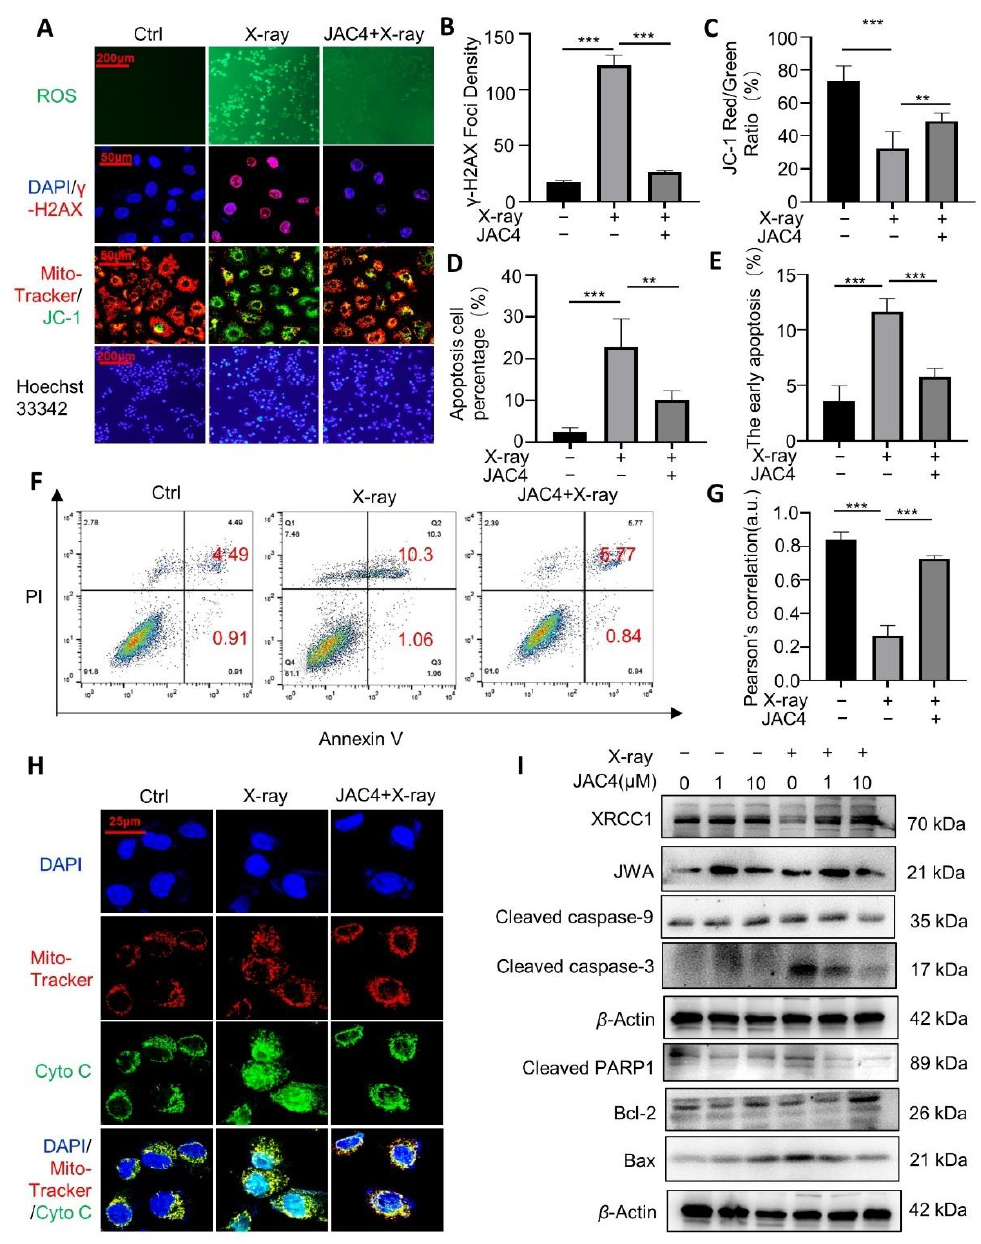
Figure 5. JAC4 attenuates X-ray-triggered oxidative stress and mitochondria damages in ICE-6 cells. ( A ) IEC-6 cells were pretreated with JAC4 (1 or 10 µ M) or DMSO for 24 h and then exposed to X-ray (12 Gy). ROS was detected by DCFH probe, apoptosis was detected by Hoechst staining, the mitochondrial membrane potential was detected by JC-1 staining, and DNA damage was detected by γ -H2AX staining after 24 h. ( B ) Quantitative analysis of γ -H2AX foci density. ( C ) JC-1 red/green ratio of IEC-6 cells after treatment. ( D ) Quantitative analysis of apoptosis cell percentage by Hoechst staining. ( E , F ) Cells were stained with Annexin V-PI and analyzed by flow cytometry at 24 h after a dose of 12 Gy of radiation, and a histogram of apoptotic cells is expressed as a percentage of total cells. ( G ) Colocalization coefficient of cytochrome c and mitochondria of IEC-6 cells after treatment. ( H ) Corresponding fluorescence images of the release of cytochrome c from mitochondria in IEC-6 cells after treatment. ( I ) Western blot analysis was performed for XRCCI, JWA, cleaved caspase-3, cleaved caspase-9, cleaved PARP1, Bax, and Bcl-2 at 24 h after administration of 12 Gy of radiation. The results are expressed as mean ± SEM ( n = 3) (** p < 0.01; *** p < 0.001; ns: p > 0.05).